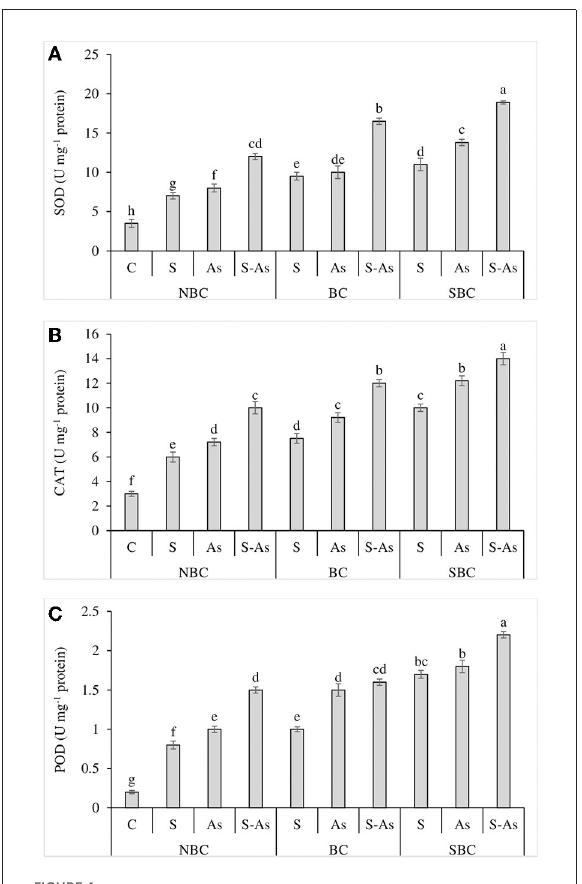
FIGURE4 Effect of salinity, arsenic, and their combination on the activities of SOD (A) , CAT (B) , and POD (C) of quinoa supplemented with no biochar (NBC), biochar (BC), and silicon-nanoparticles doped biochar (SBC). The values (average ± SE of four replicates) followed by different letters represent the significant difference at a significance level of